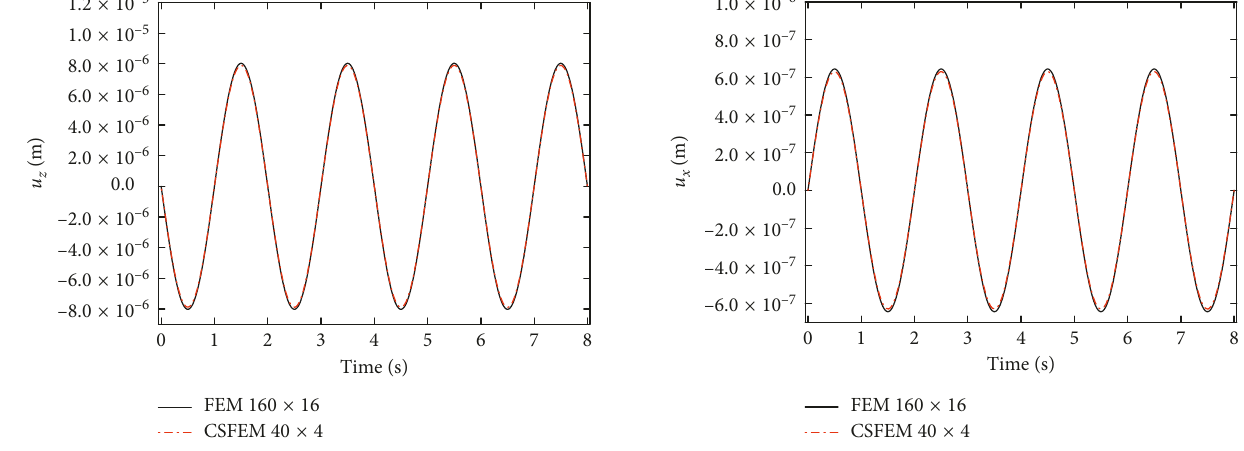
x at point B with